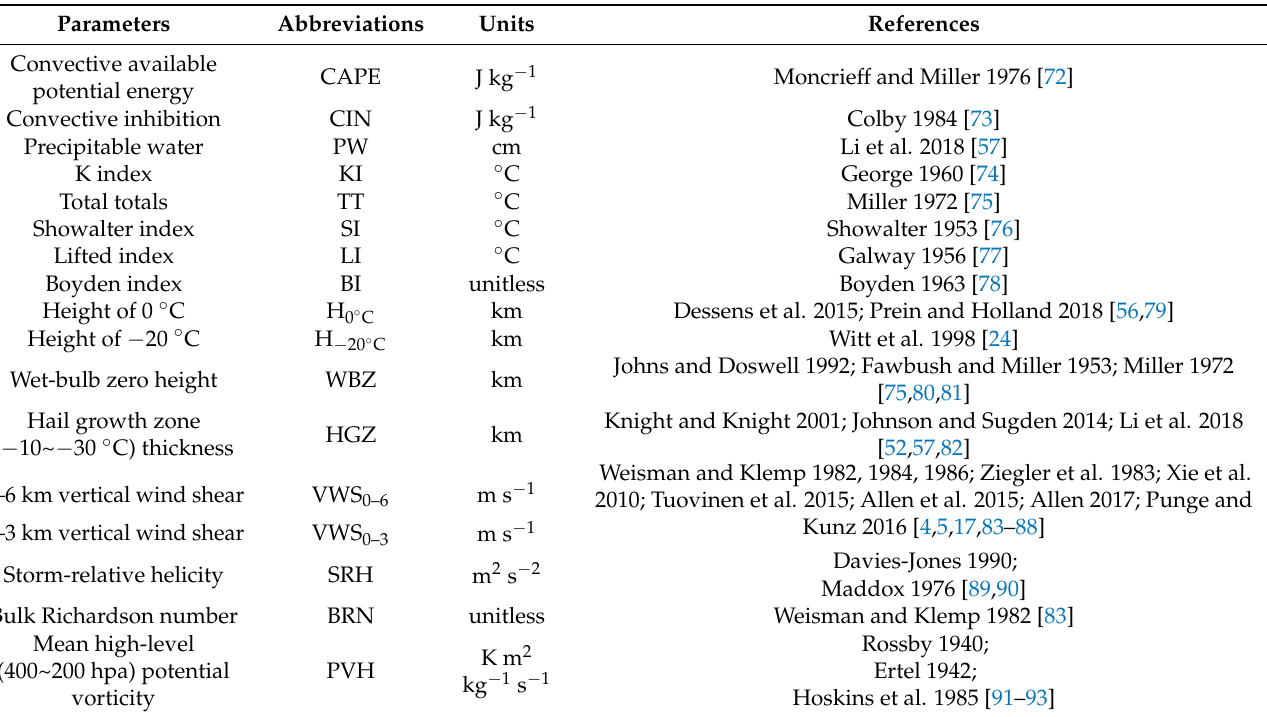
Table 1. List of environmental parameters.